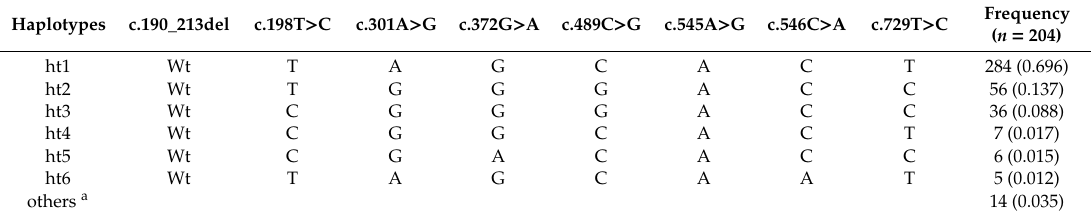
Table 2. Haplotype frequencies of 8 PRNP polymorphisms in the canine PRNP gene.